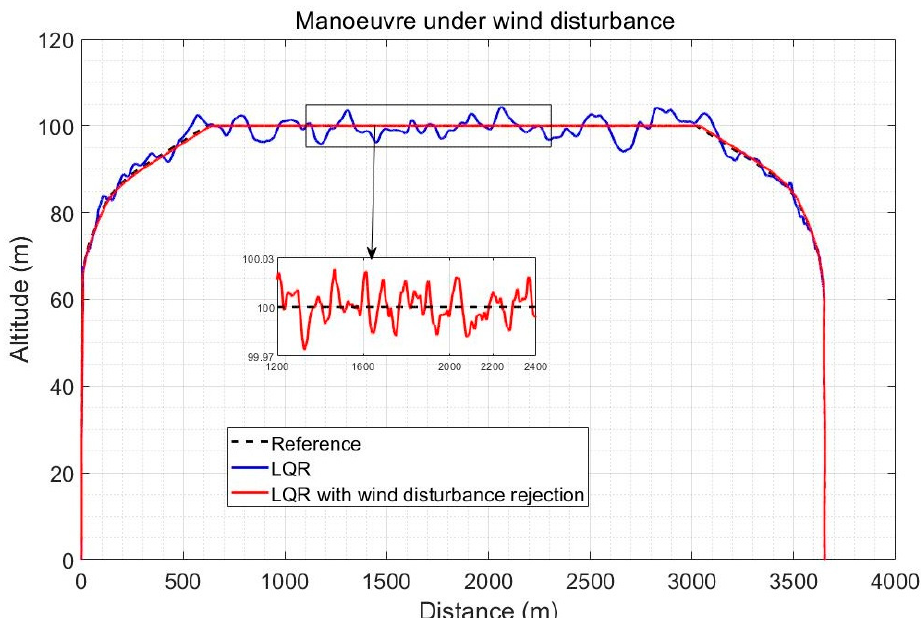
Figure 10. Altitude response comparison during a climb-cruise-land trajectory under an average wind intensity of 5 m/s.